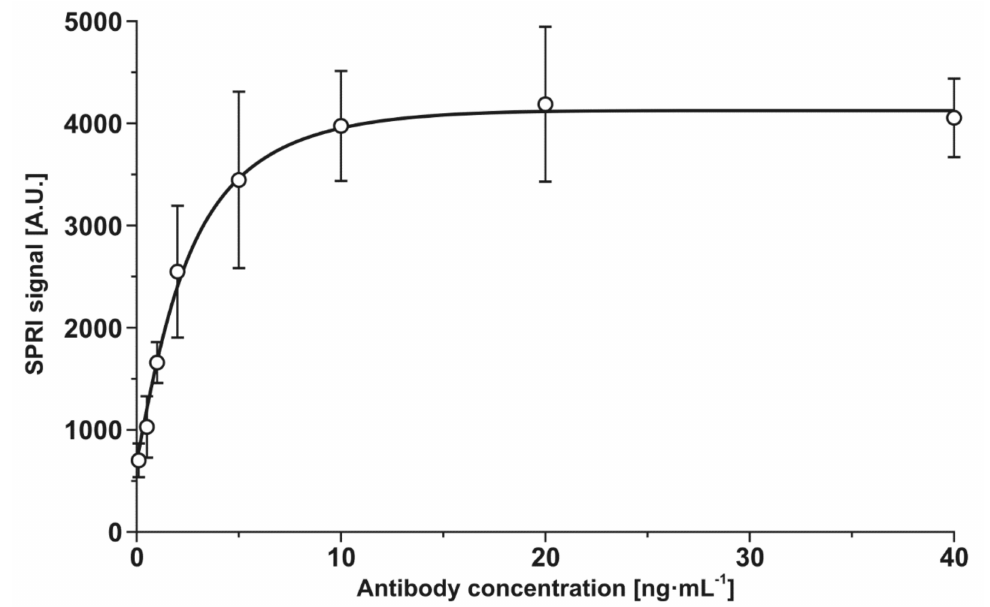
Figure A1. Dependence of the analytical signal on the concentration of rabbit polyclonal antibody against HE 4, at an HE 4 concentration of 114